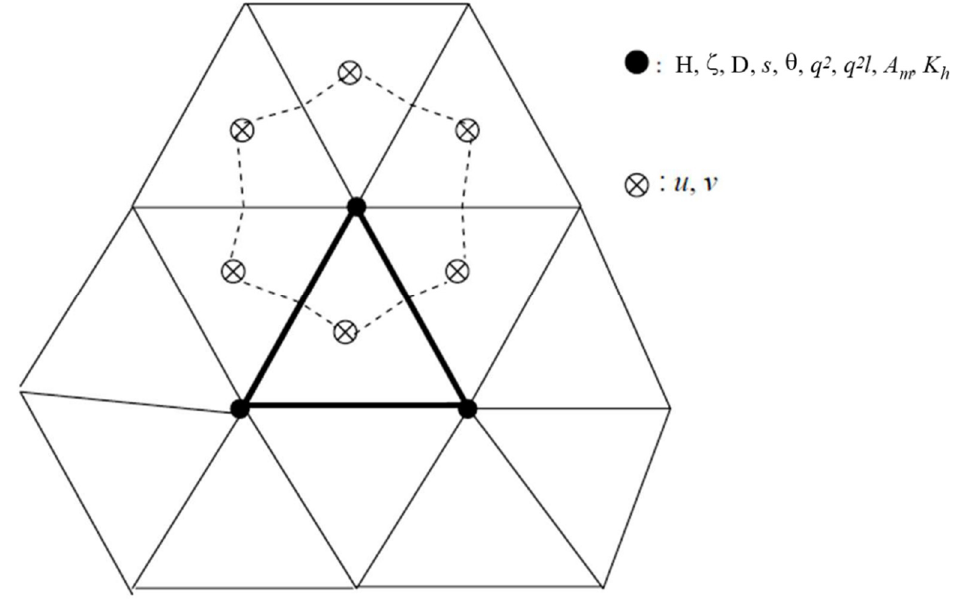
Figure 1. Locations of velocity and tracer variables in the unstructured grid of FVCOM.